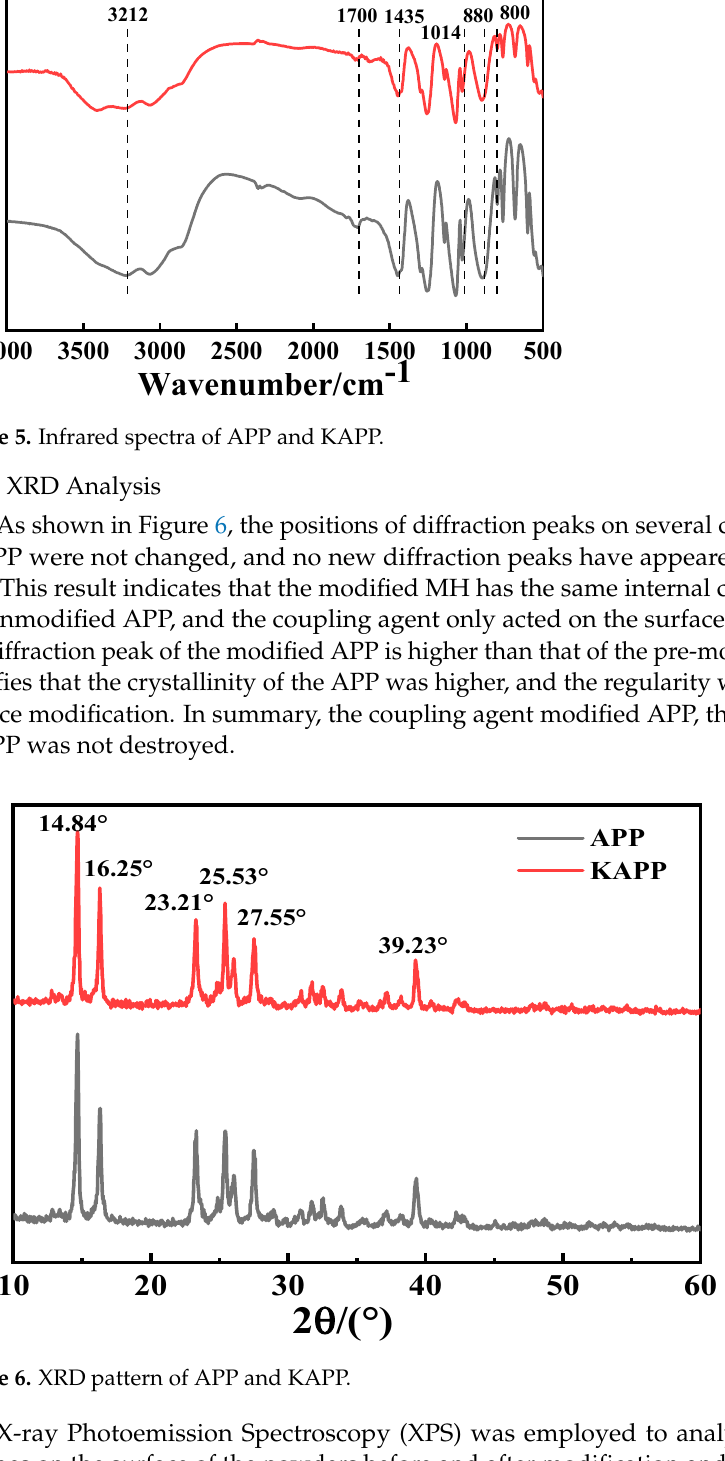
Figure 7. XPS profiles of APP and KAPP all elements ( a ) and P 2p ( b ). 0